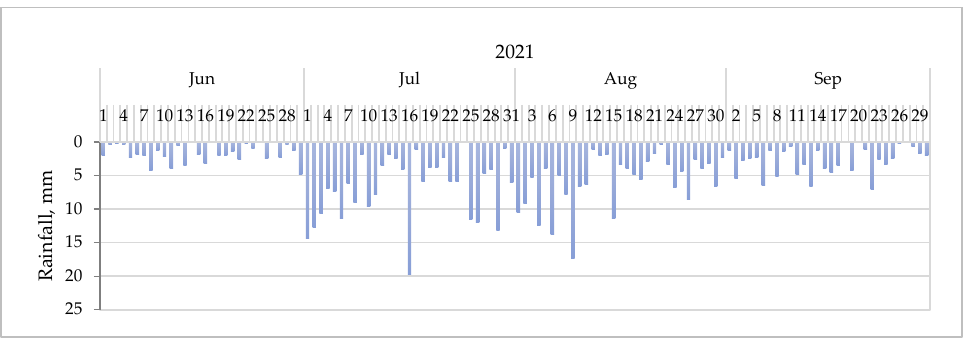
Figure 8. Bias-corrected mean daily rainfall for the JJAS 2021 flood season over the basin. The spatial distribution of the rainfall over the study basins showed that the upper catchment receives more rainfall, which induces more runoff to trigger flooding (Figure 9). In other words, the rainfall magnitude decreases from the headwater of the model basins to the lowland areas in both time and